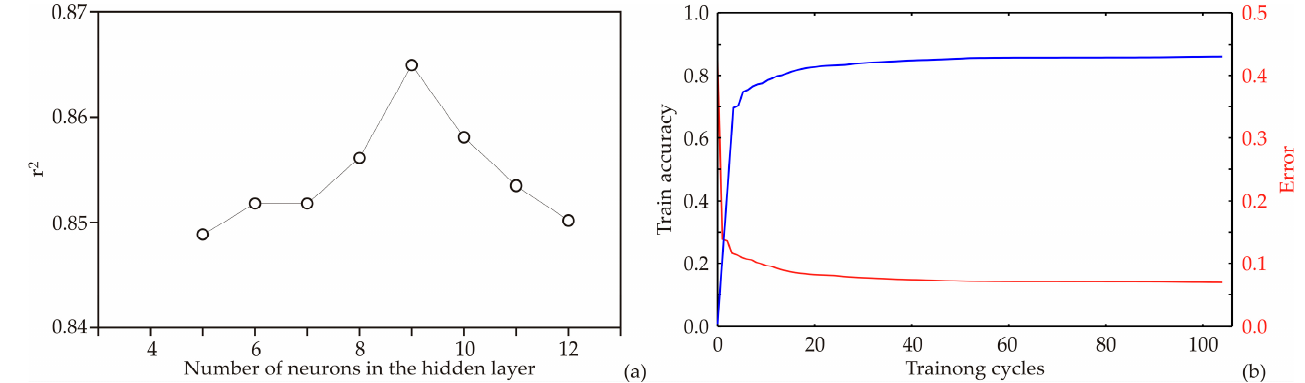
Figure 1. ANN calculation : ( a ) The dependence of the r 2 value of the number of neurons in the hidden layer in the ANN model, ( b ) Training results per epoch.